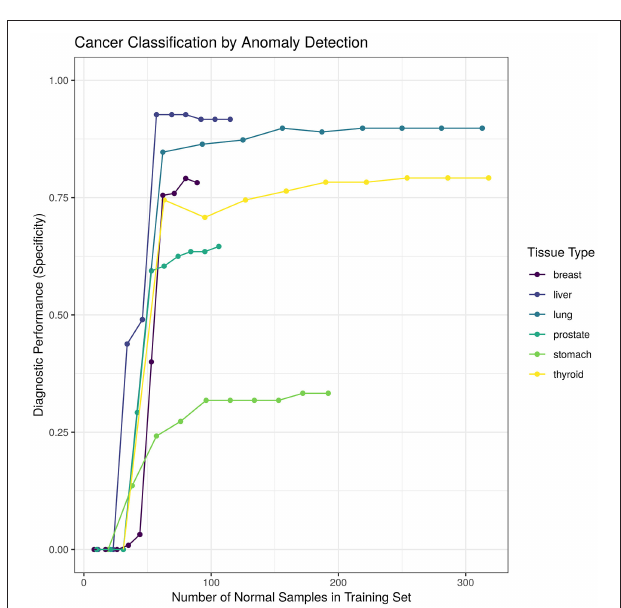
averaged across 10 bootstraps of the GTEx training set. This figure shows performance for TCGA test set only; no TCGA samples were included in the training